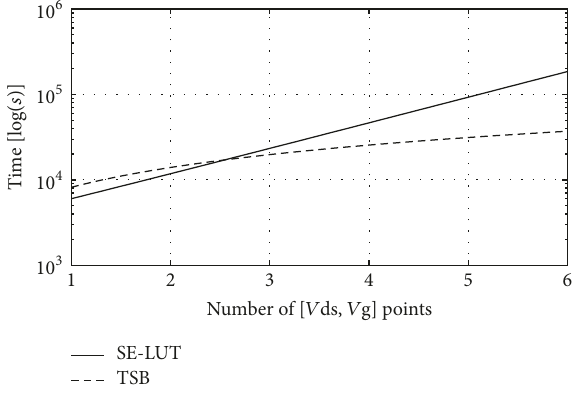
Figure 20: Timing comparison of SE-LUT and TSB